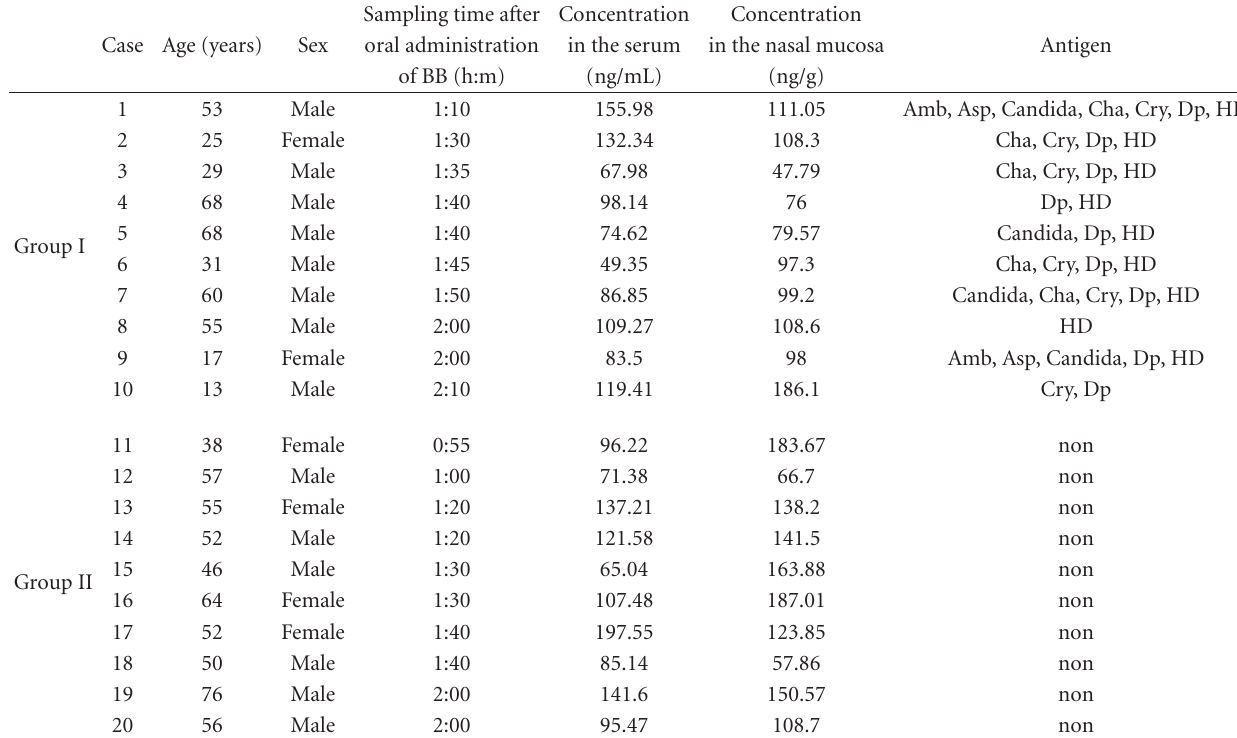
Table 1: Characters of the participants and results of the concentration of BB in the serum and nasal mucosa. Sampling time after Concentration